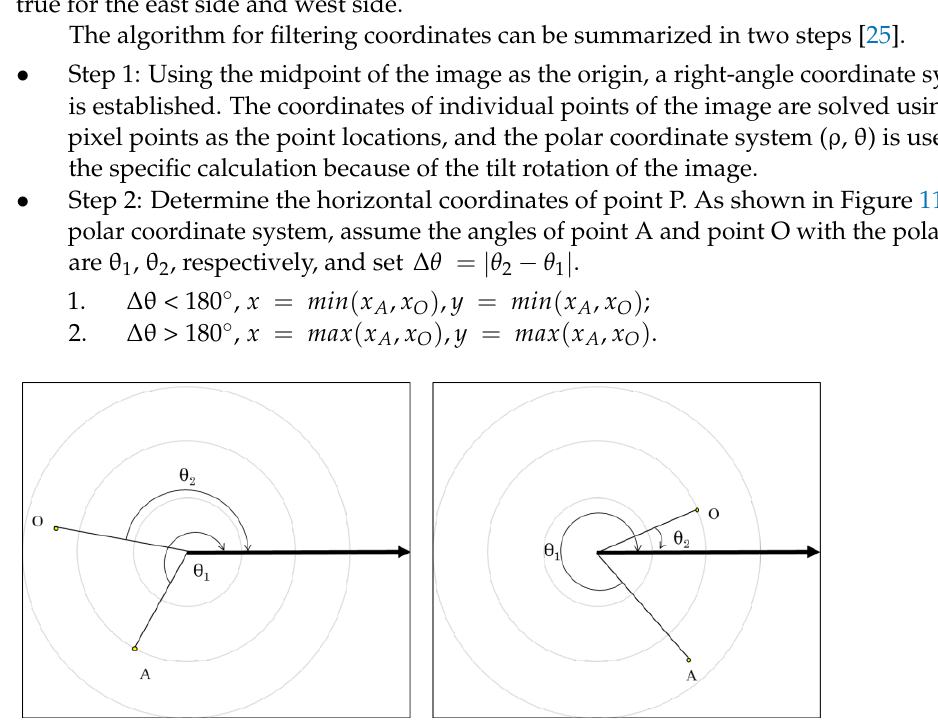
Figure 11. Schematic diagram of the coordinate filtering algorithm.